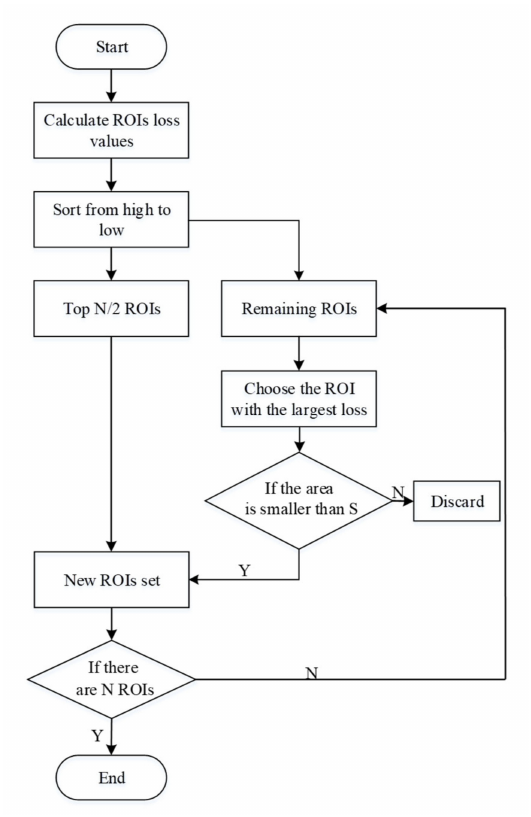
Figure 5. Region of interest (ROI) mining